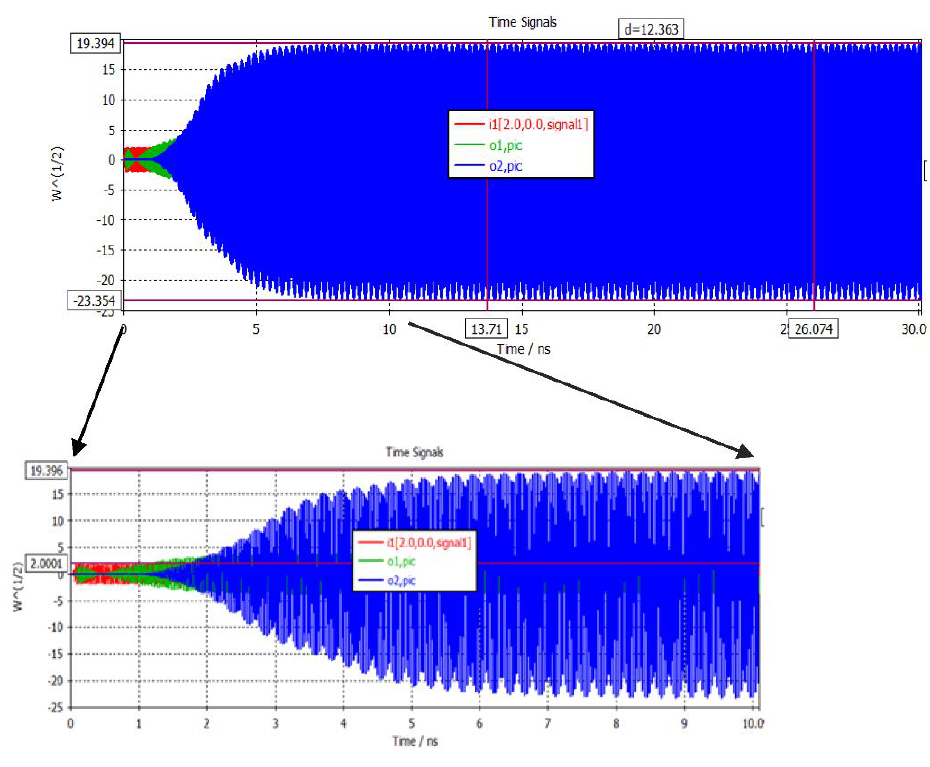
Figure 15. Port signals (combined view) of RF section.